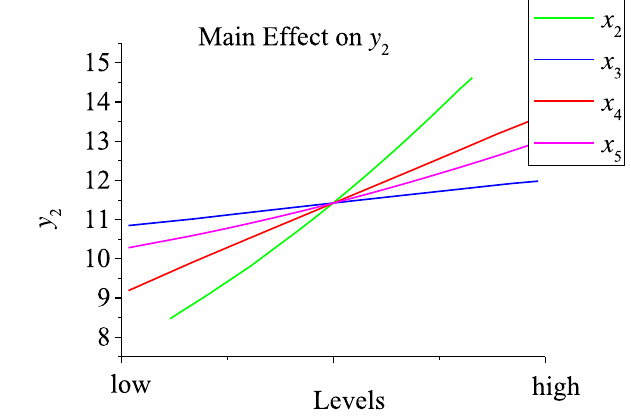
Fig. 15. Main effect for all design variables.